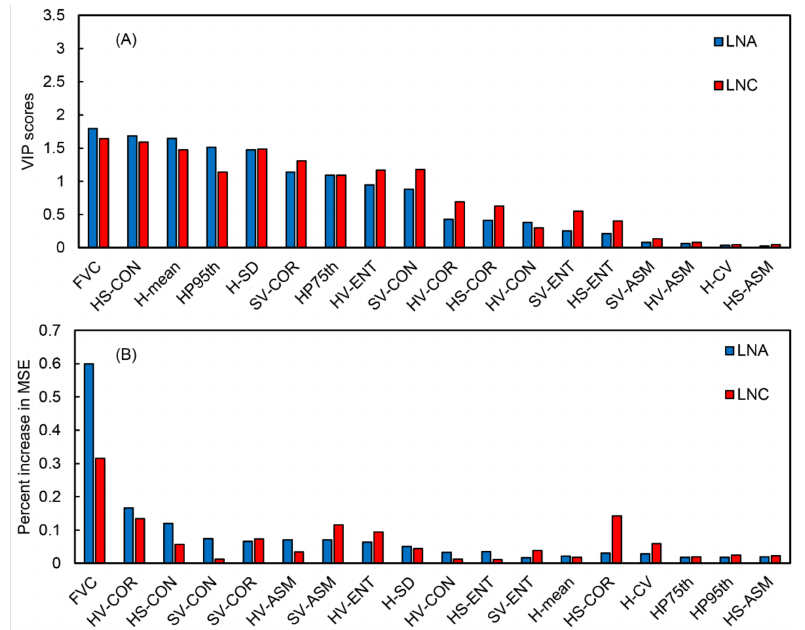
Figure 13. Importance of different features in PLS ( A ) and RF ( B ) models with canopy structural features as the input